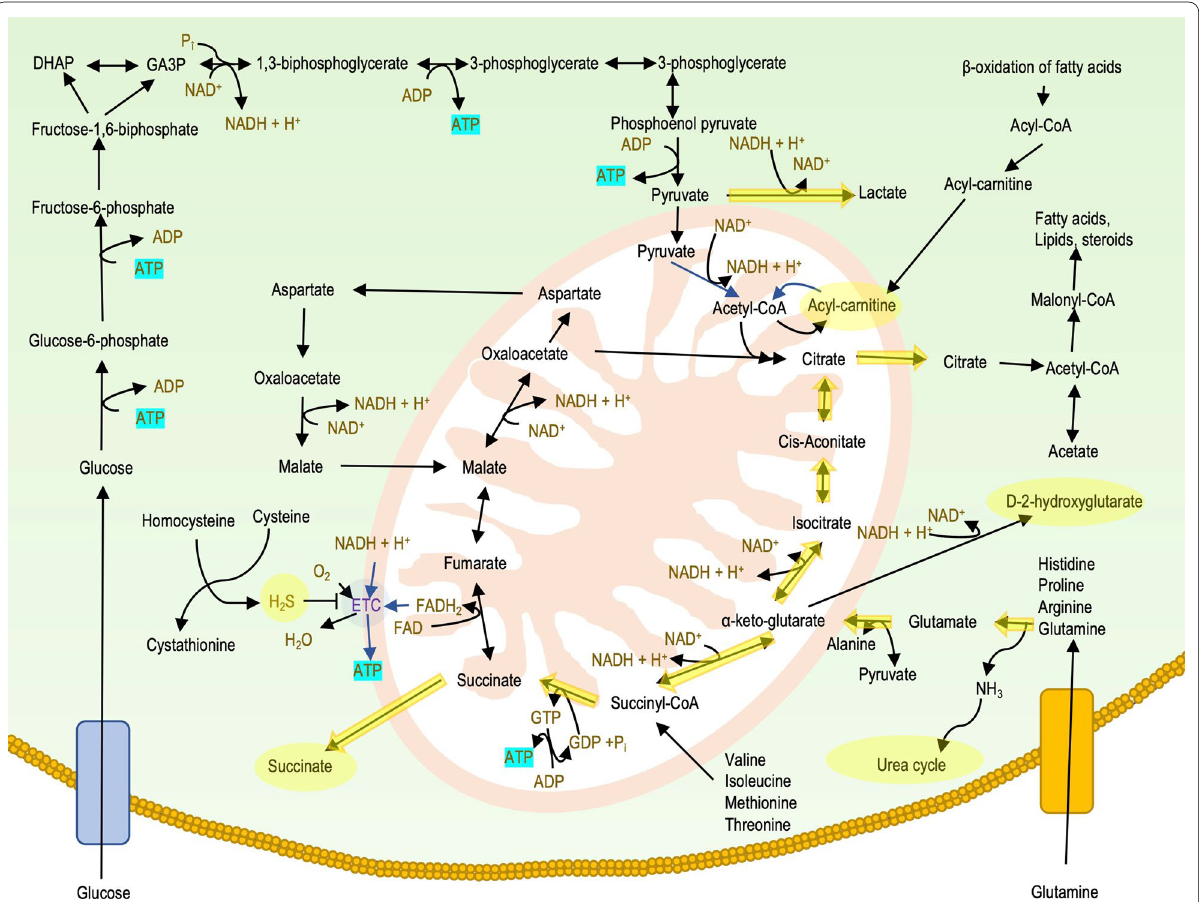
Fig. 6 Metabolic and bioenergetic alterations in DS. Upregulated pathways and metabolites are highlighted in yellow. As mitochondrial oxidative phosphorylation is suppressed in DS, cells downregulate various proteins of the electron transport chain and re-wire their energetic pathways. Glycolysis is upregulated, producing ATP and as a byproduct, lactate. Because the mitochondrial NADH consumption is inhibited, NADH does not enter the mitochondria through the malate-aspartate cycle, but, rather, it is converted back to NAD + by lactic fermentation. As pyruvate is transformed into lactate, it does not enter the cyclic acid cycle. Similarly, lipids are also inhibited to enter the Krebs cycle and they are accumulated in the form of acyl-carnitines. As another compensatory pathway, glutamine, glutamate and other amino acids enter the Krebs cycle as 2-oxoglutarate and generate GTP, which can immediately be transformed to ATP and NADH. To oxidize the NADH, the Krebs cycle can run in reverse direction, thus producing citrate. As a result, various metabolites and enzymes involved in cyclic acid cycle are upregulated. As cells use amino acids as an alternative energy source, excess ammonia is generated (this can, in turn, be eliminated via the urea